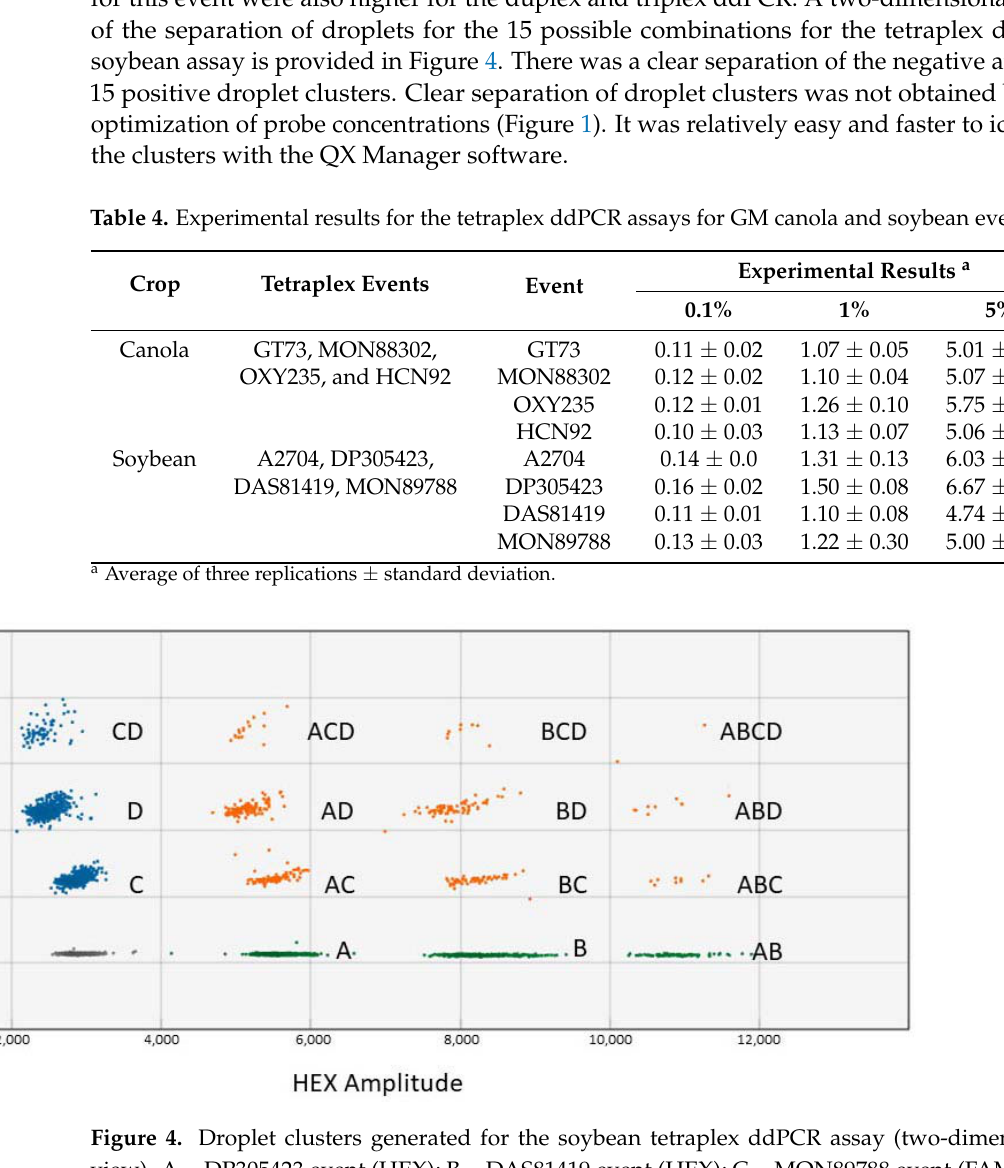
Table 4. Experimental results for the tetraplex ddPCR assays for GM canola and soybean events.